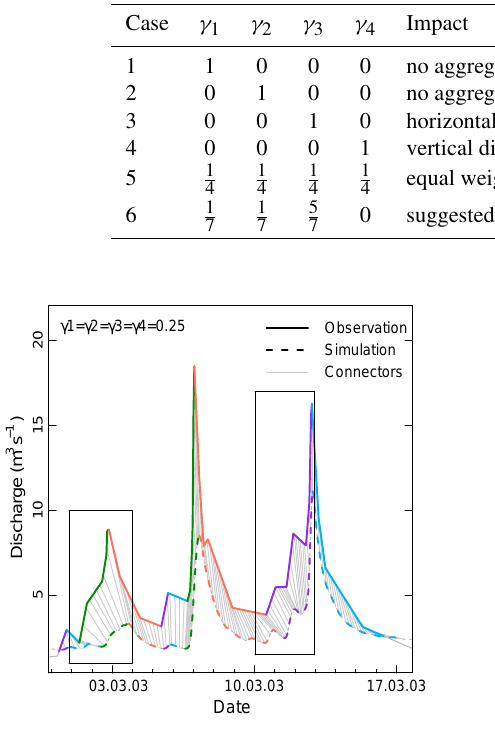
Figure 5. Optimal coarse-graining solution of the event depicted in Fig. 3 if equal weights ( γ parameters) are applied to the objective function θ (Eq. 2). In this case the coarse-graining procedure selects different edge nodes for two segments (see black boxes) leading to slightly larger timing and smaller magnitude errors compared to the bottom left panel in Fig.